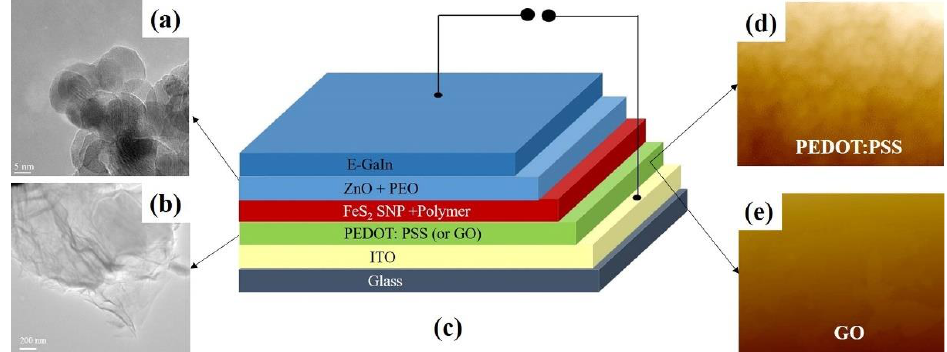
Figure 1. ( a ) TEM image of zinc oxide, ( b ) TEM image of graphene oxide, ( c ) device architecture of FeS 2 SNPs with GO and ZnO as the carriers charge transportation layer, ( d ) AFM image of ITO/PEDOT:PSS, and ( e ) AFM image of ITO/GO.